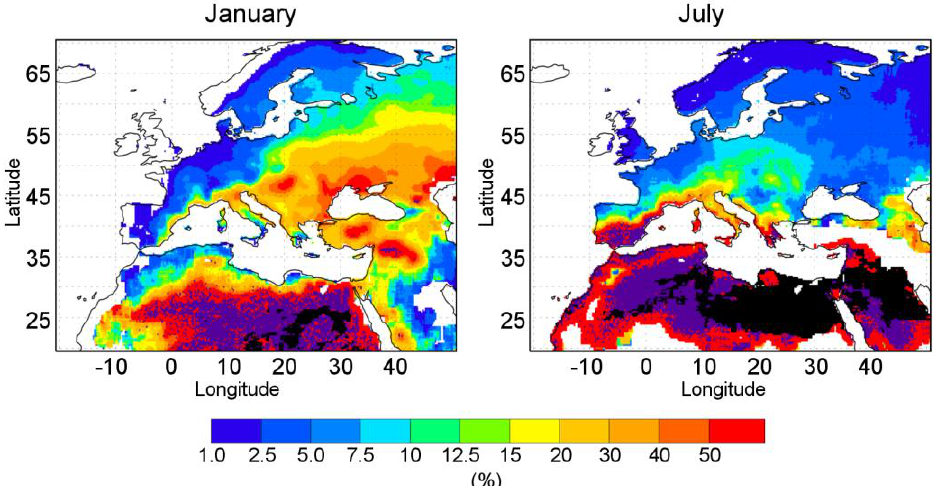
Figure 8. Monthly climatological percentage of the Mediterranean moisture contribution (PFLEX-Cli) to precipitation (MSWEP-Cli) during January (right panel) and July (left panel). Violet represents percentage values of 100% and a black color indicates those regions where the MSWEP precipitation dataset does not show values. White areas are those regions where PFLEX-Cli does not report values.